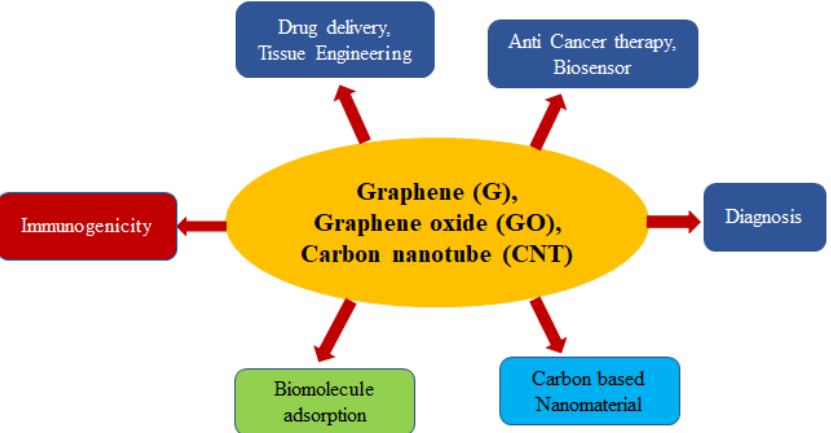
Figure 1. Biomedical applications of nano based materials.